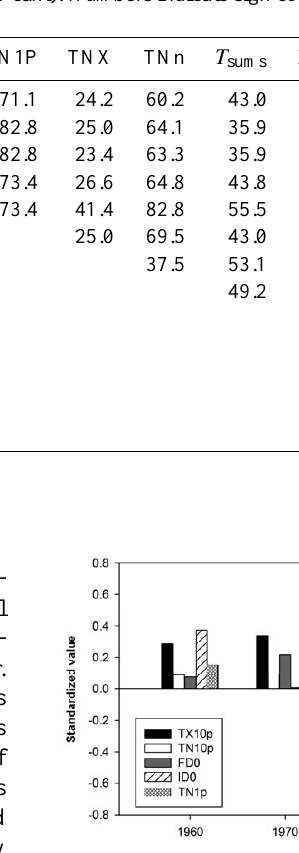
Table 4. The association between pairs of cold and variability extreme indices with respect to the sign of the trends at the 95% level (statistically positive, statistically negative, and statistically insignificant). Numbers indicate sign coincidences for each pair of the indices.